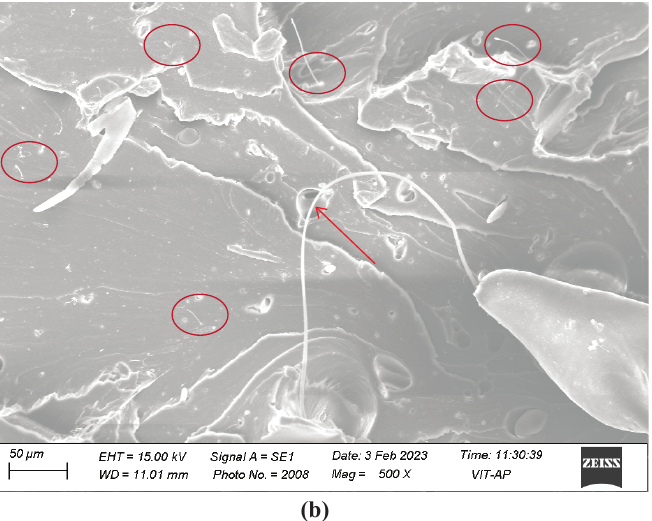
Figure 4. SEM images of 1 wt% ( a ) MWCNT-reinforced and ( b ) HNT-reinforced shape-memory polymer nanocomposites. The red color circled ones indicates dispersed